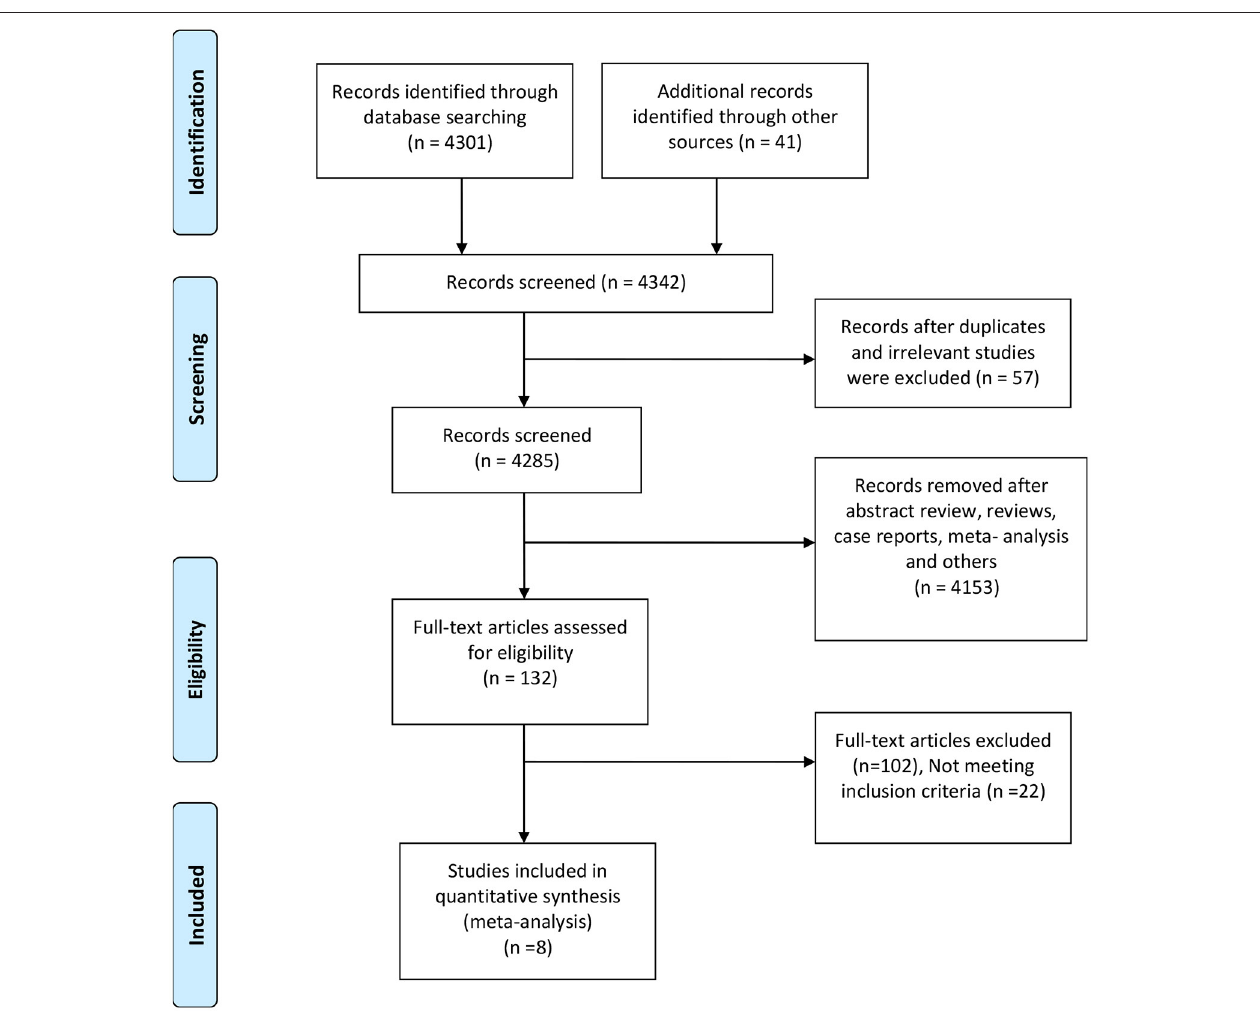
FIGURE 1 | Preferred reporting items for the systematic review and meta-analysis study flow diagram for the literature